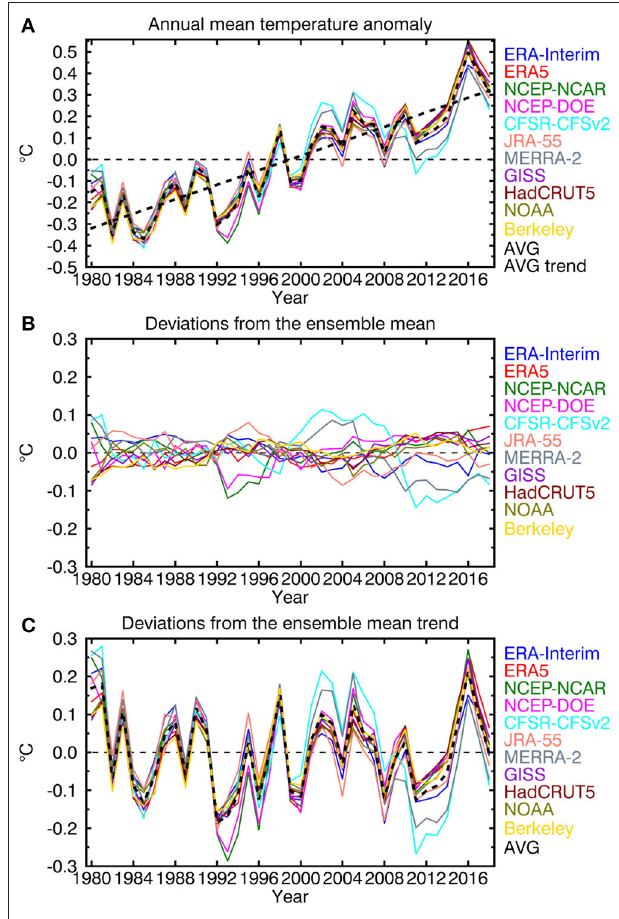
FIGURE 1 | Globally averaged observation-based (A) anomalies of annual mean temperature X k from the 1980 to 2018 average; (B) deviations X ∗ k X k X A of individual analyses from the ensemble mean X A ; and (C) = − X k α A t around the ensemble mean linear trend. The thick deviations X ′′ k = − dashed curves in the top and bottom panels correspond to the ensemble average X A and the thick black dashed line in the top panel is the ensemble mean linear trend α A t for the